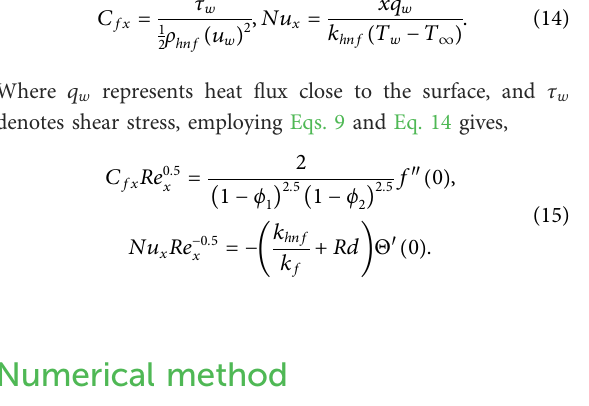
ϕ (cid:2) 0 . 02 , k (cid:2) 0 . 2 , Gr (cid:2) Gr * (cid:2) Rd (cid:2) 0 . 3 , B 1 , 2